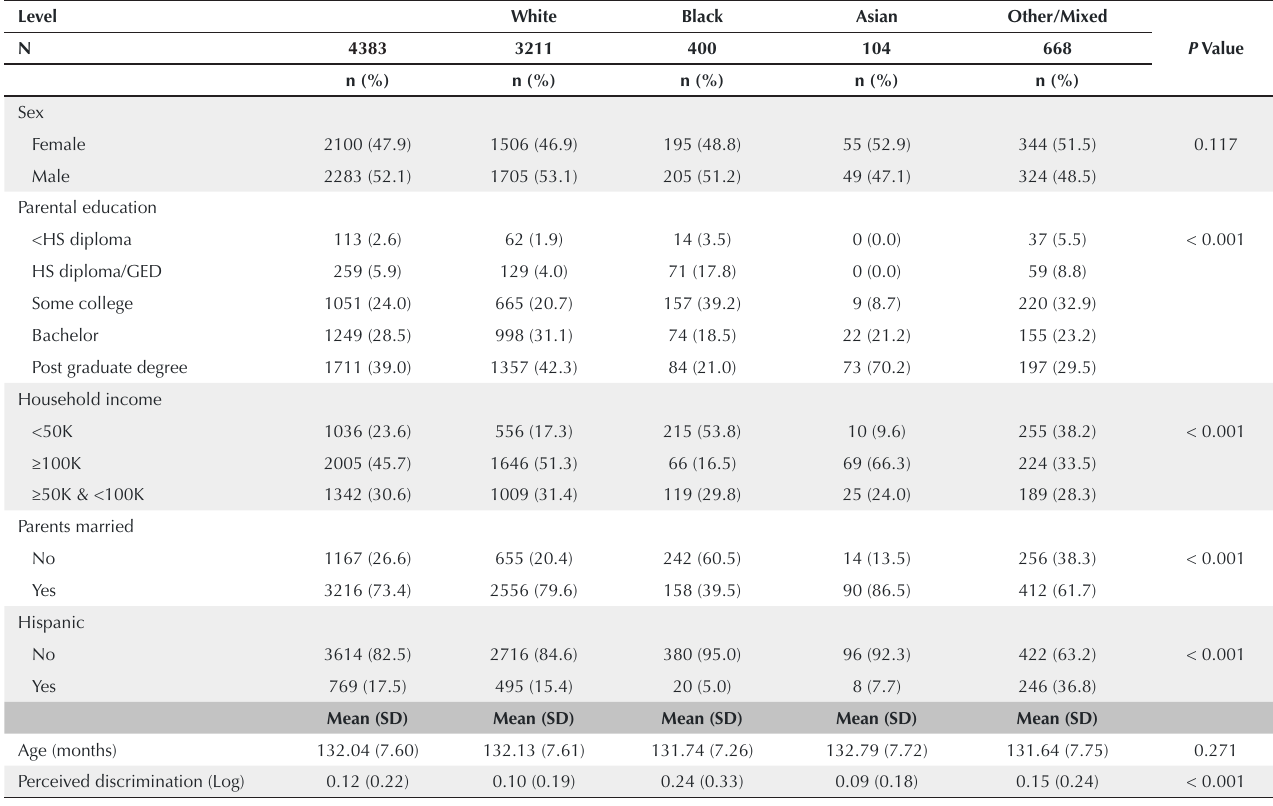
Table 1. Demographics Descriptive Data in the Pooled Sample by Race